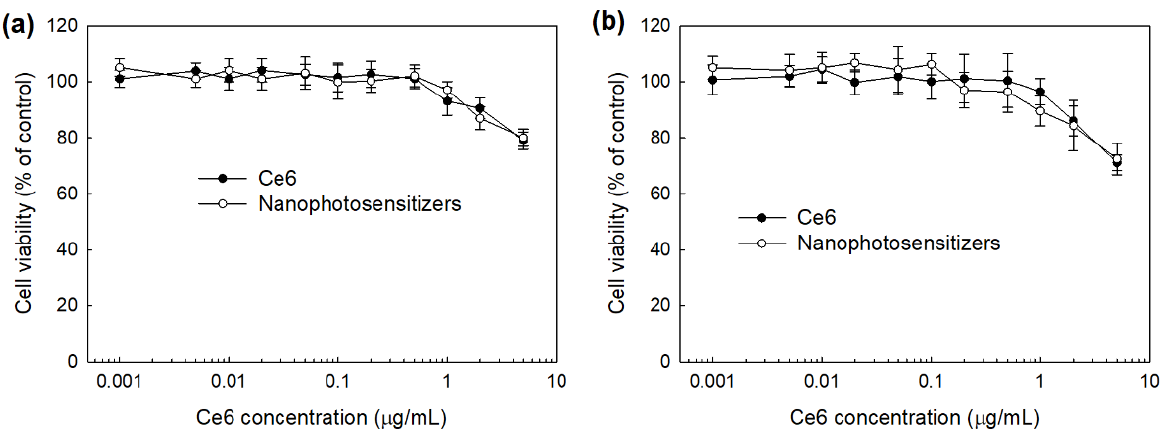
Figure 8. Intrinsic cytotoxicity of free Ce6 or mPEGseseCe6PBAP nanophotosensitizers against RAW264.7 cells ( a ) and HeLa cells ( b ). Free Ce6 or mPEGseseCe6PBAP nanophotosensitizers treated to RAW264.7 mouse macrophage cells or HeLa human cervical cancer cells in the absence of light.